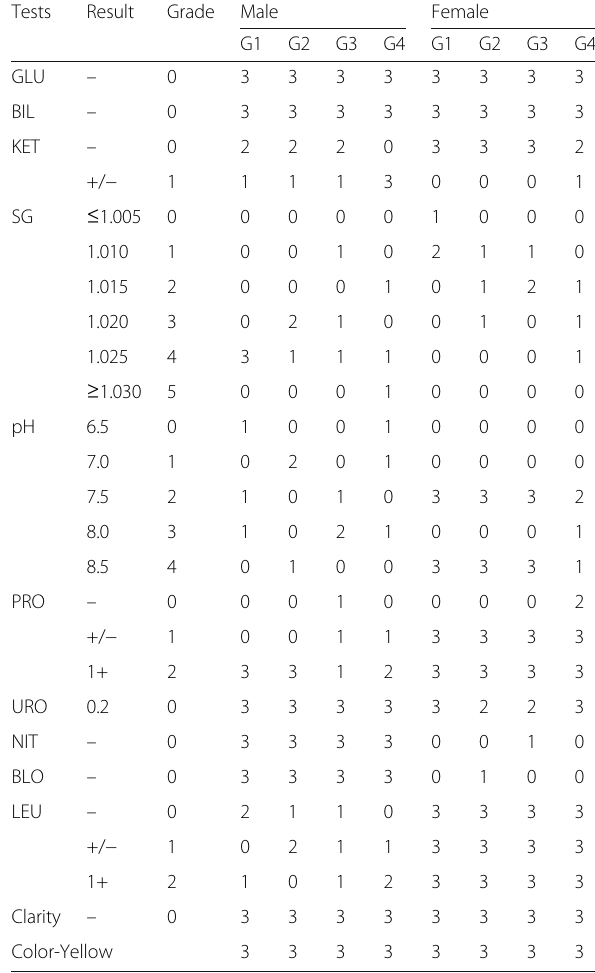
Table 2 Effect of oral administration of OE on urinalysis parameters in male and female